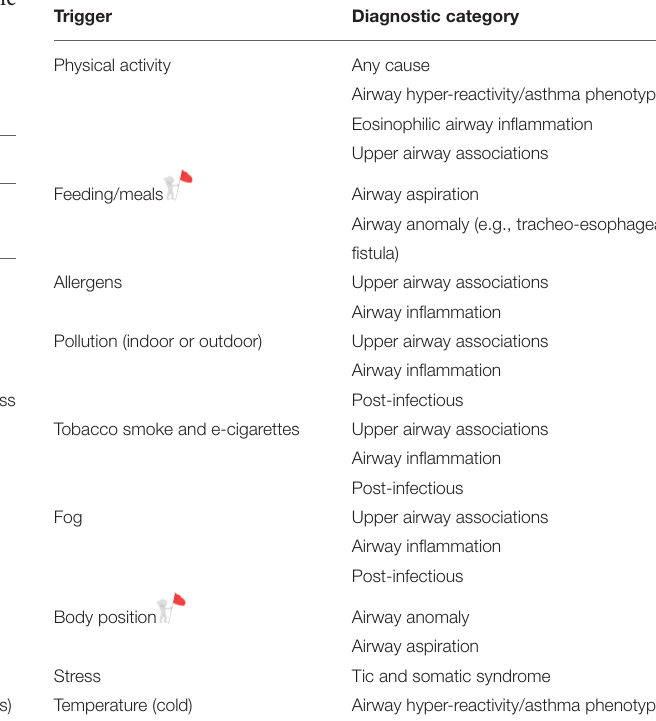
TABLE 8 | Triggers of cough and potential diagnostic